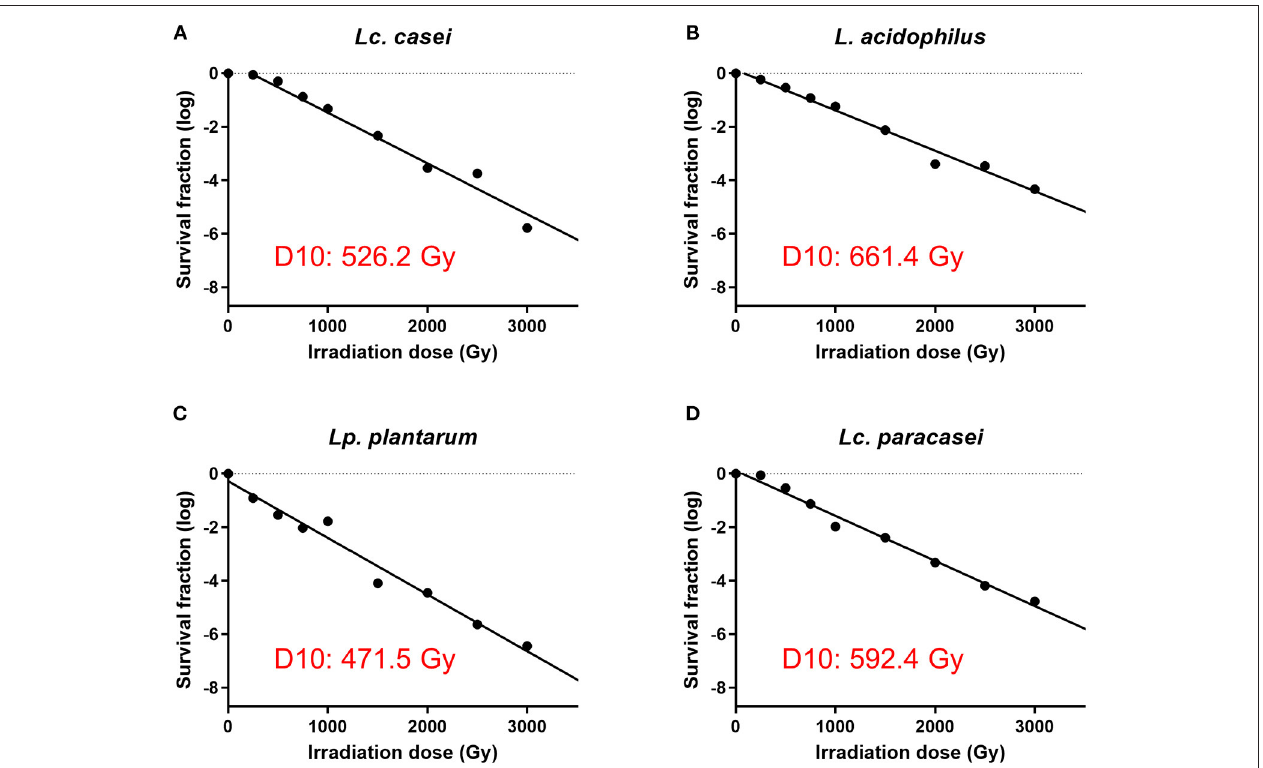
FIGURE 1 | Assessment of surviving fraction at increasing irradiation doses and calculation of the D10 value. The four strains of LAB were irradiated with eight increasing doses of gamma irradiation (250, 500, 750, 1,000, 1,500, 2,000, 2,500, and 3,000Gy) and the surviving fraction of bacteria was enumerated. D10 value of each strain was calculated using the inverse of the slope of the regression lines ( − 1/slope) of gamma irradiation dose against survival fraction (log) using GraphPad Prism 9. D10 values are as follows: 526.2Gy for Lacticaseibacillus casei (A) , 661.4Gy for Lactobacillus acidophilus (B) , 471.5Gy for Lactiplantibacillus plantarum (C) , and 592.4Gy for Lacticaseibacillus paracasei (D)